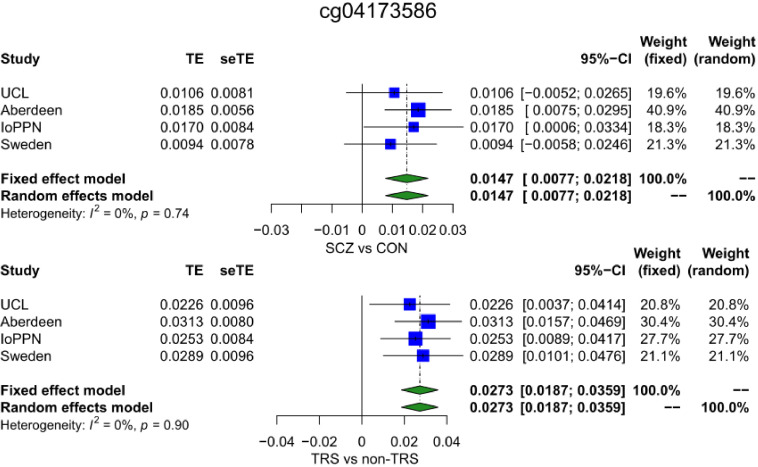
Forest plot of a site where DNA methylation is significantly associated with schizophrenia and within cases, with treatment-resistant schizophrenia.TE: treatment effect (i.e., the mean difference between cases and controls); seTE: standard error of the treatment effect.